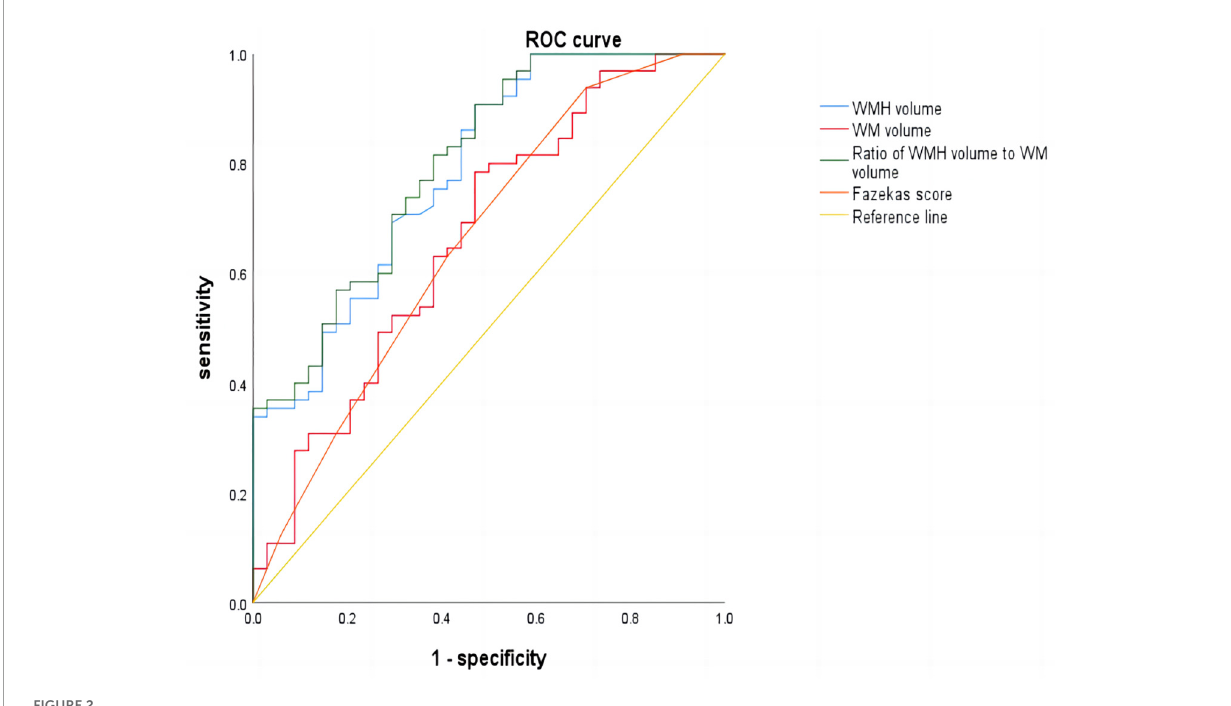
FIGURE2 Receiver operating characteristic (ROC) curve.